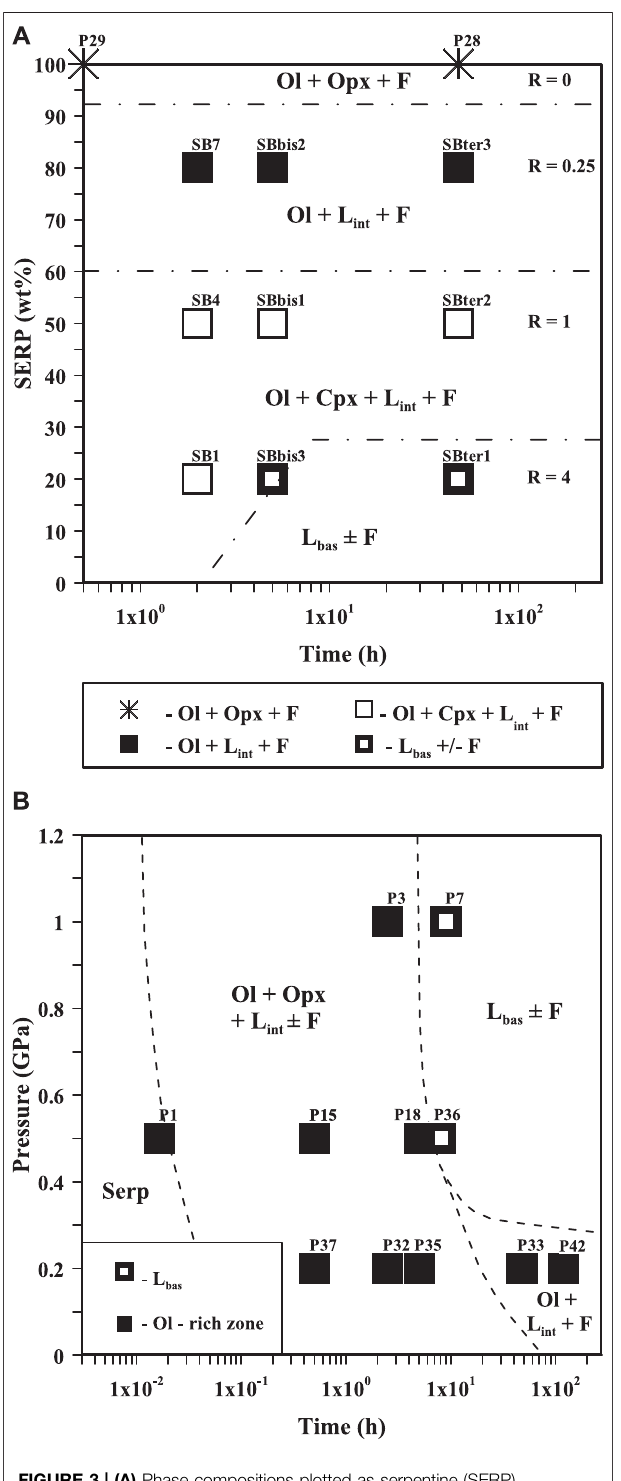
FIGURE 3 | (A) Phase compositions plotted as serpentine (SERP) proportion (in wt%) vs. run duration (h) for the pure serpentinite dehydration experiments ( R (cid:1) 0) and mixed serpentinite-basalt reaction experiments at 0.2 GPaand1,250 ° Candbasalt-to-serpentiniteratios R (cid:1) 0.25,1and4. The diagram shows mineral, glass, and fl uid phase associations observed after quenching. Ol, Opx, Cpx, L int , L bas , and F stand for olivine,